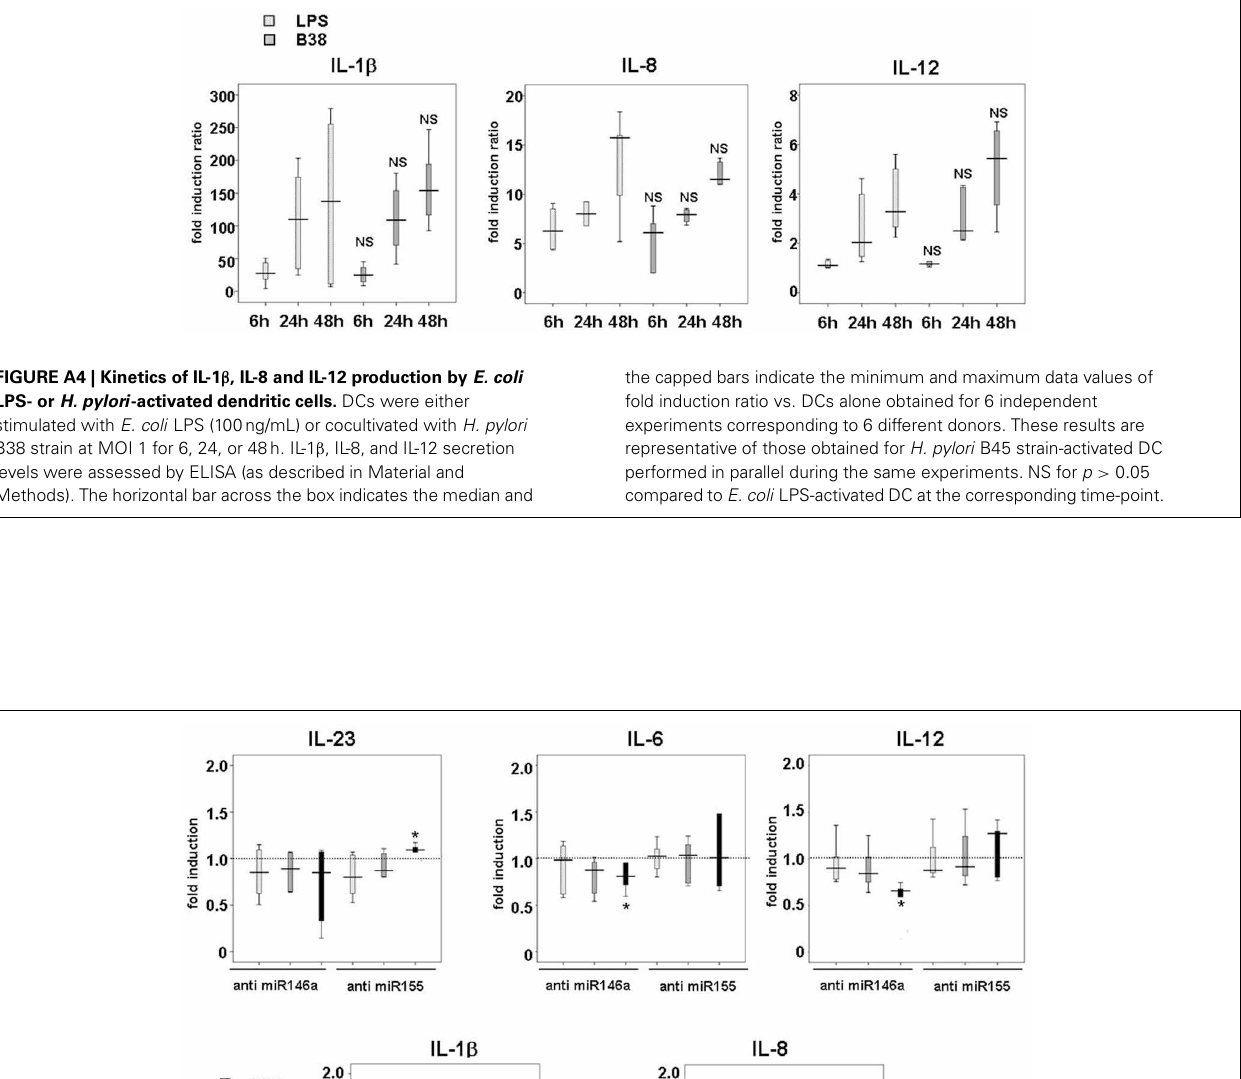
cytometry, whereas IL-1 β , IL-8, IL-12, and IL-23 production were assessed by ELISA. The horizontal bar across the box indicates the median and the capped bars indicate the minimum and maximum data values of fold induction ratio compared to scrambled oligonucleotide-treated cells, for 4 independent experiments corresponding to 4 different donors (*if p < 0 .